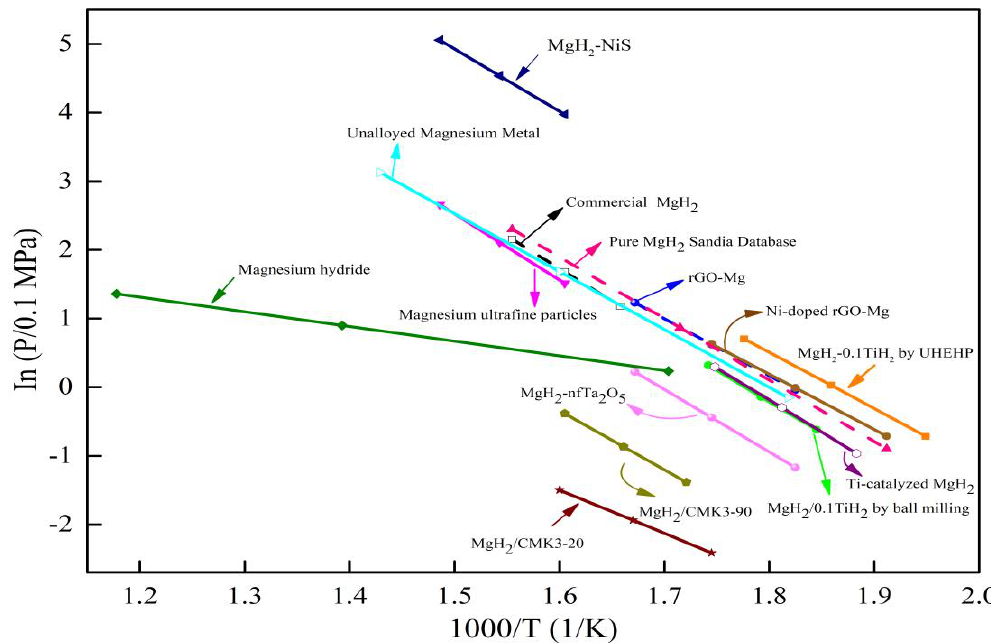
Figure 3. The van’t Hoff plots of the desorption reaction for various Mg-MgH 2 systems.